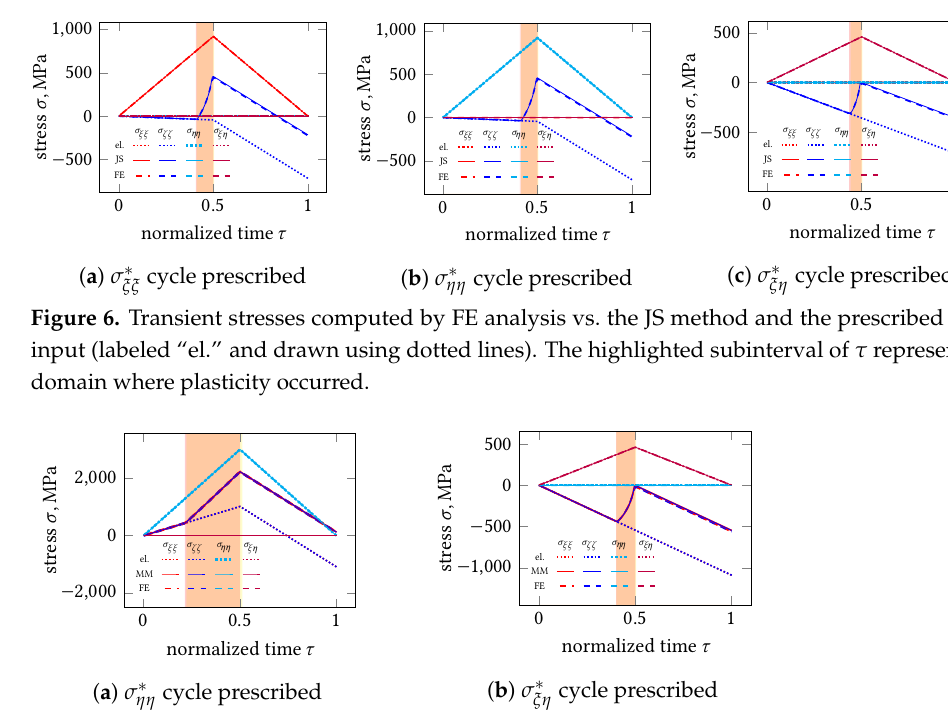
Figure 7. Transient stresses computed by the FE analysis vs. the MM method and the prescribed elastic input (“el.”, dotted lines). Plasticity occurred within the highlighted subinterval of τ .